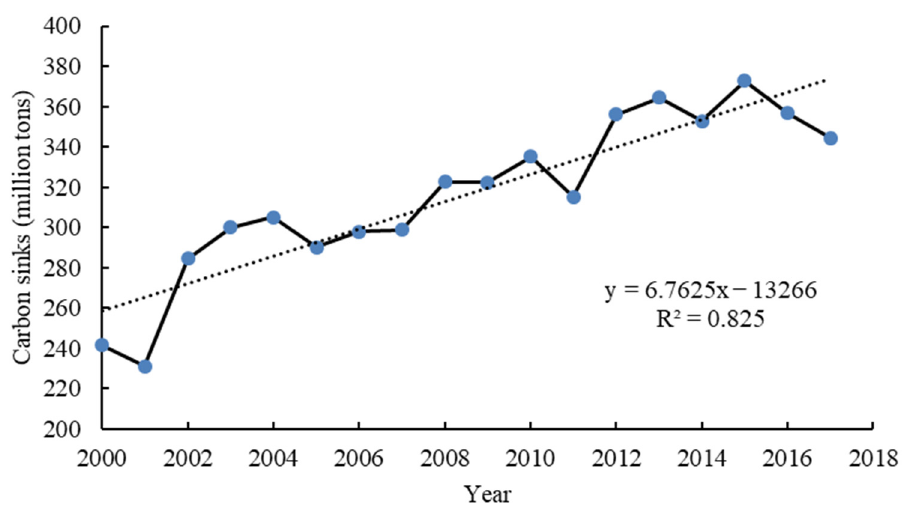
Figure 2. Temporal evolution of carbon sinks in Shaanxi Province.